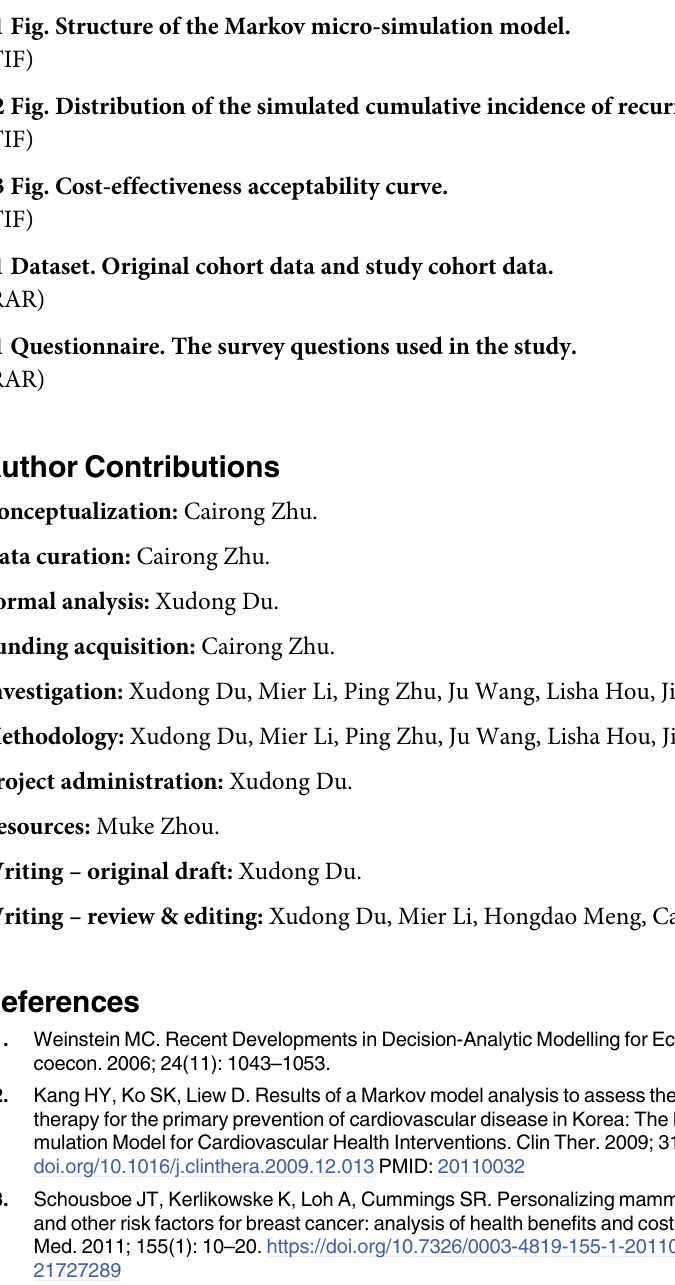
S1 Table. Sex-age- death probabilities (3 months). S2 Table. Baseline cumulative hazard estimated using the FPSM and Cox model. S1 Fig. Structure of the Markov micro-simulation model. S2 Fig. Distribution of the simulated cumulative incidence of recurrent ischemic stroke. S3 Fig. Cost-effectiveness acceptability curve. S1 Dataset. Original cohort data and study cohort